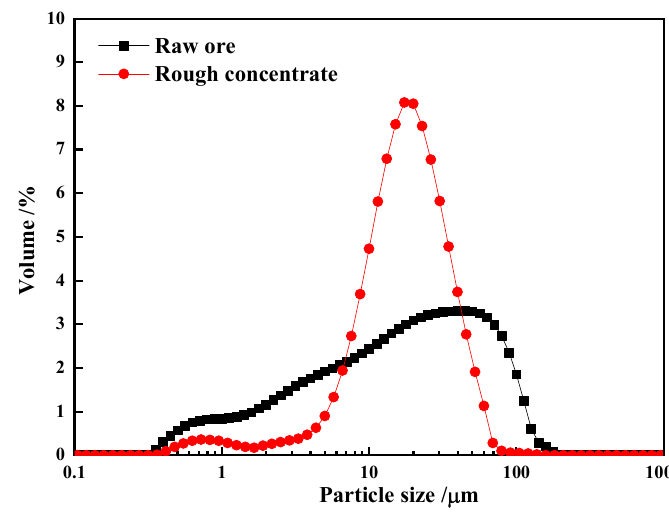
Figure 6. The particle size distribution of the raw ores and the rougher concentrate.